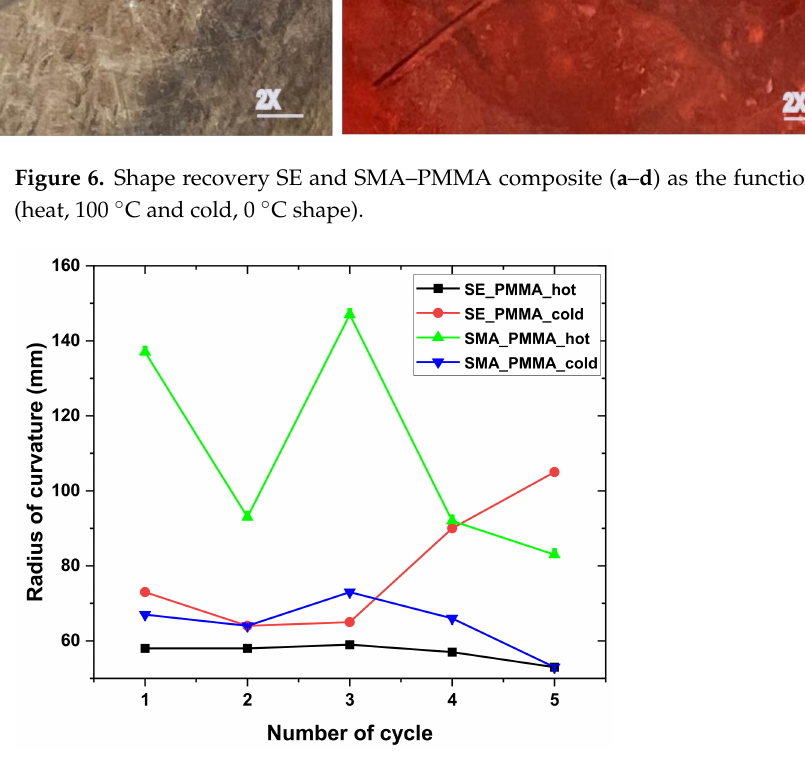
Figure 7. Radius of curvature as the function of the number of cycles for SE and SMA–PMMA